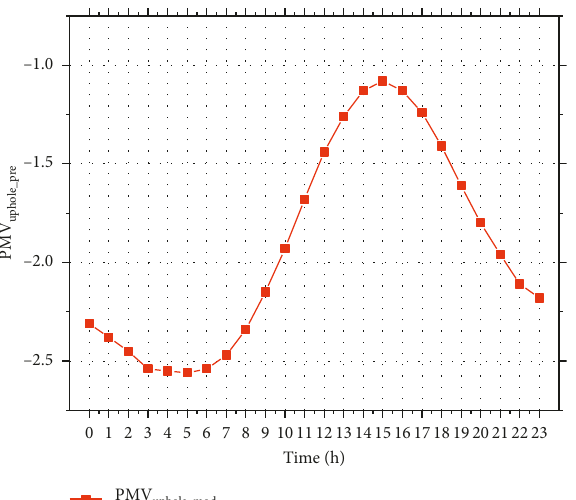
Figure 3: Predicted hourly thermal comfort data in the uphole